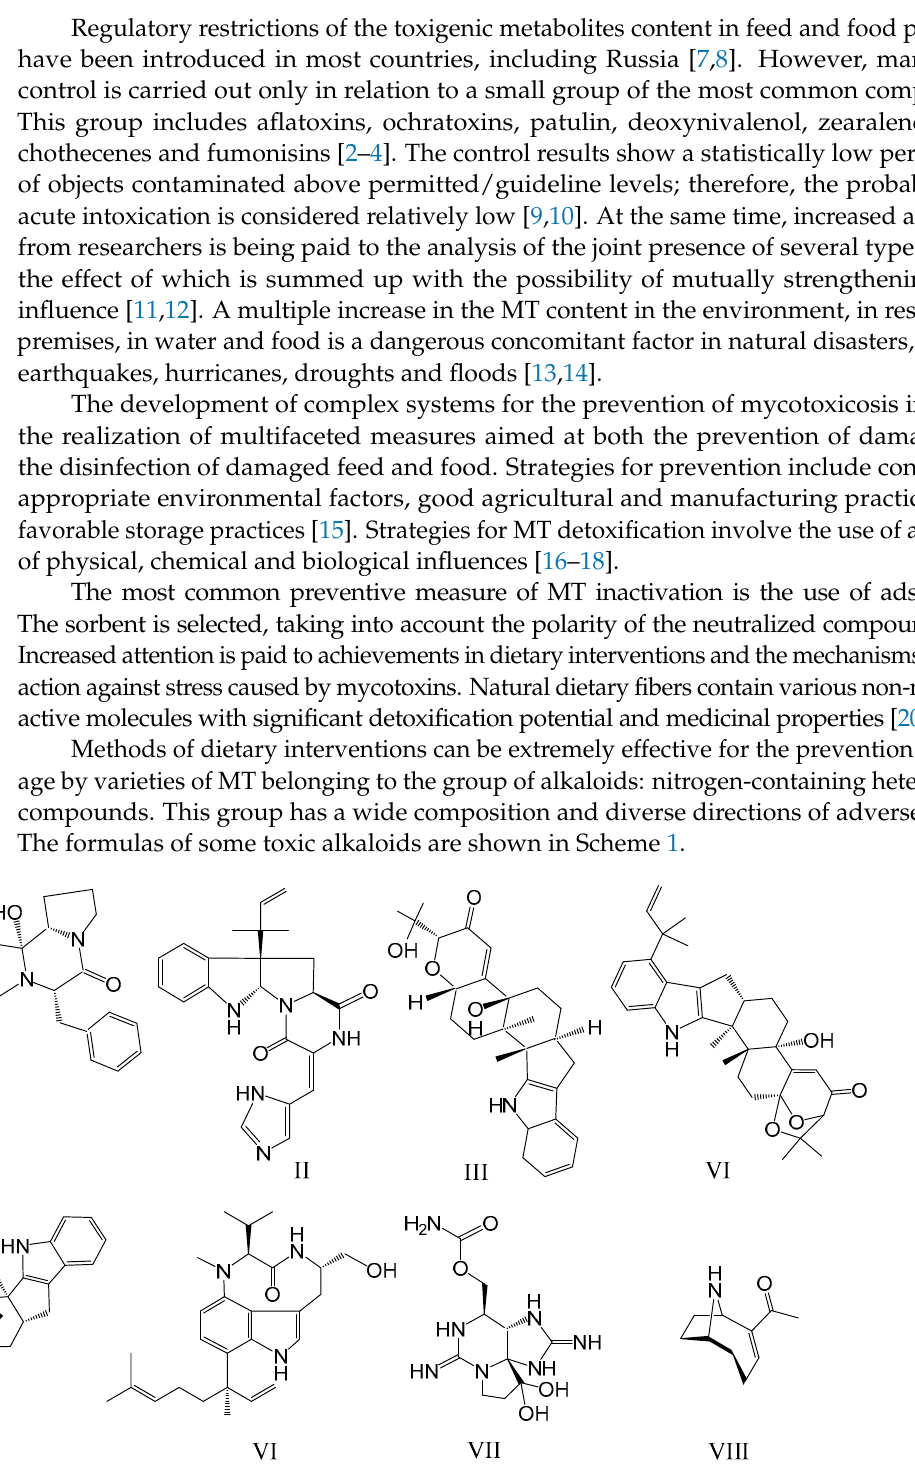
Scheme 1. Structure of mycotoxins structure from azaheterocyclic compounds group